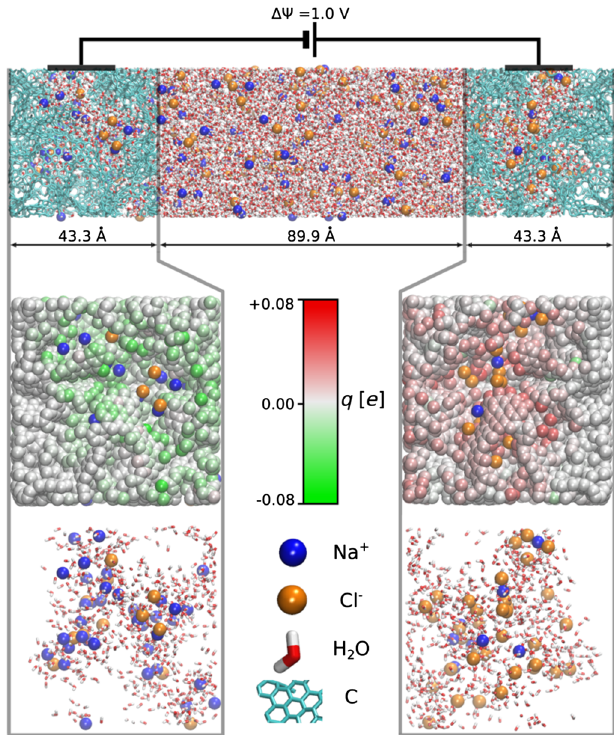
FIG. 1. The simulated system (top panel) consists of two nano- porous carbon electrodes, with a structure corresponding to carbide-derived carbons synthesized at 800 °C (cyan lines) and an aqueous NaCl solution as an electrolyte (here at 1 M; sodium is shown in blue, chloride in orange, oxygen in red, and hydrogen in white). A potential difference of 1 V is applied between the electrodes, and the charge q of each electrode atom fluctuates in response to the instantaneous configuration of the electrolyte (see the color scale in the central panels, wherewater is notshown). The bottom parts illustrate the electrolyte confined in the